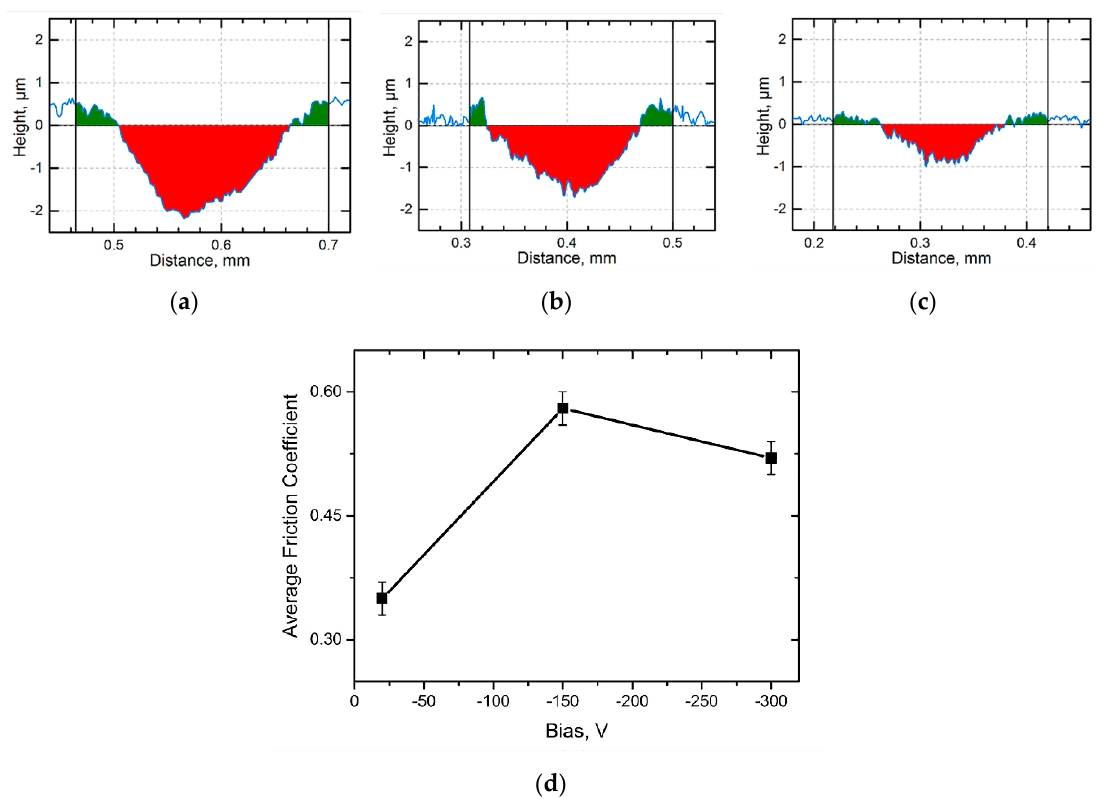
Figure 15. Results of tribological investigation of CrN/MoN multilayer coatings: ( a – c ) profilograms of the wear tracks during tribological test with Al 2 O 3 counterbody for samples with bilayer thickness of 0.6 µ m, 0.25 µ m and 44 nm, respectively; ( d ) dependence of the average friction coefficient on the bias voltage applied to the substrate. Reprinted with permission from [100] 2018 Elsevier.